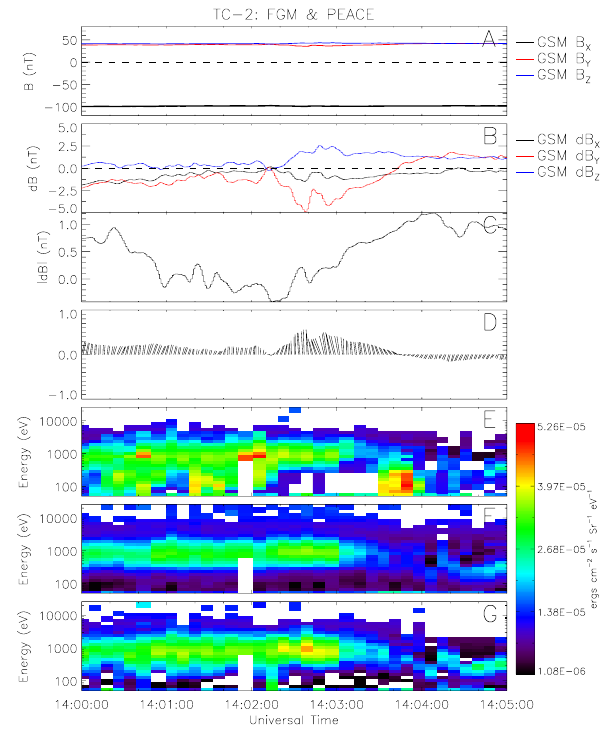
Fig. 9. Data from the FGM and PEACE instruments on board Dou- ble Star TC-2. Panel (A) shows the 3 GSM components of magnetic field, panel (B) the 3 GSM components of magnetic field with the mean field subtracted and panel (C) | d B | . Panel (D) is a feather plot showing rotations in the magnetic field that indicate the pres- ence of field-aligned currents near the spacecraft, and panels (E) , (F) and (G) electron energy time spectrograms for electrons with pitch angles of 0, 90 and 180 degrees,